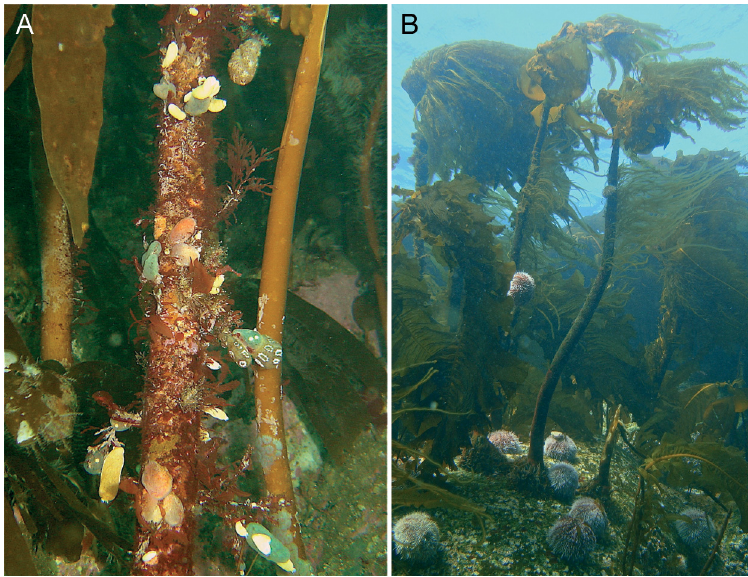
Fig. 2. Examples of typical stipe epiphytic communities found on Laminaria hyperborea . (A) Well-developed epiphytic community on a canopy plant and a young stipe with little epiphytic macroalgae growth. (B) Grazing by the sea urchin Echinus esculentus on the stipe, especially on the epiphytes on the